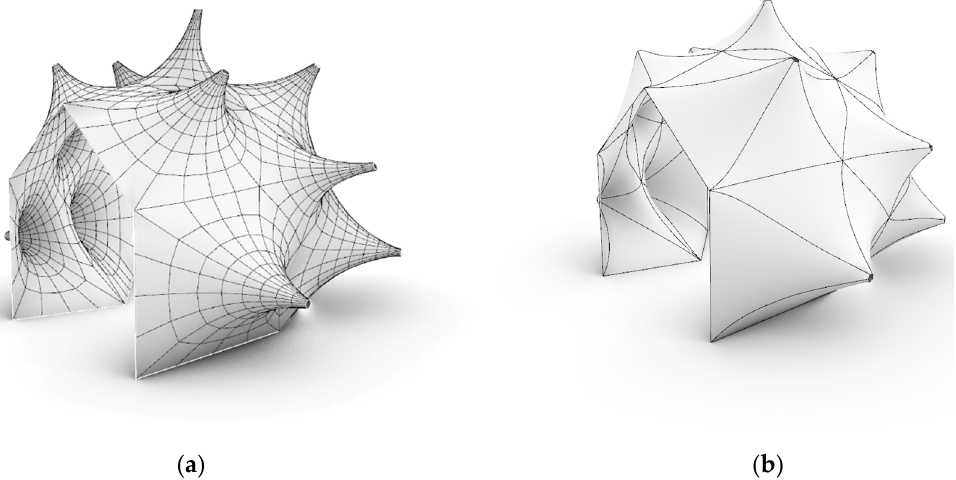
Figure 9. Comparison of two models: ( a ) minimizing edge lengths of mesh; ( b ) isogeometric analysis of NURBS surfaces.